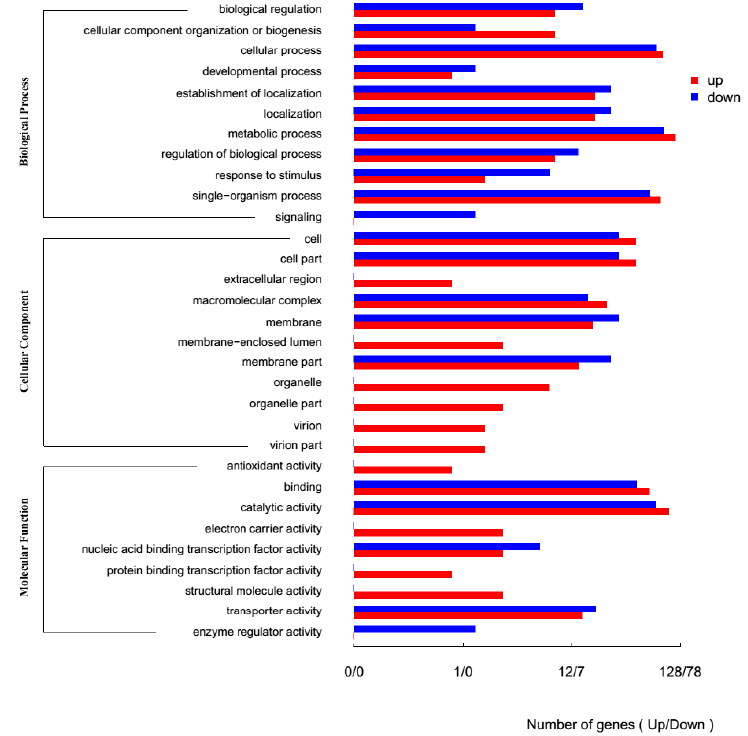
Figure 4. The GO annotations of differentially expressed genes of Bacillus atrophaeus Ua.